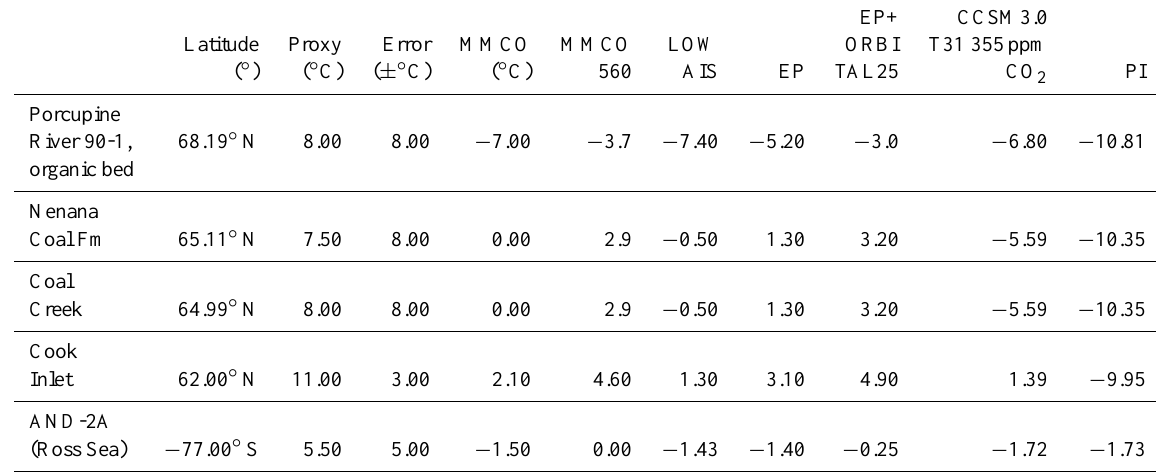
Table 3. High latitude model proxy data comparison for the Alaskan and Antarctic records. The simulations in the comparison include CESM1.0 and CCSM3.0 (Herold et al., 2011) model runs.